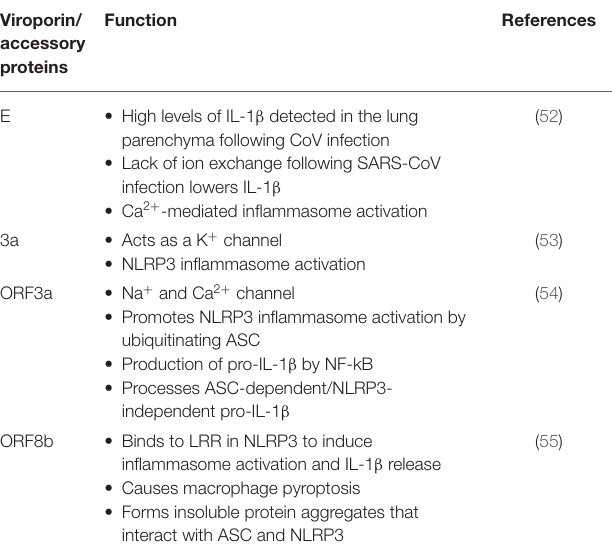
TABLE 1 | CoV proteins and their role of inflammasome